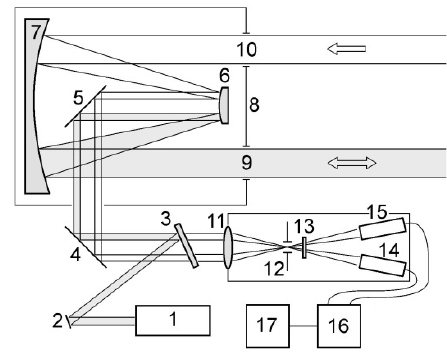
Fig. 1. Block diagram of the micro pulse BSA